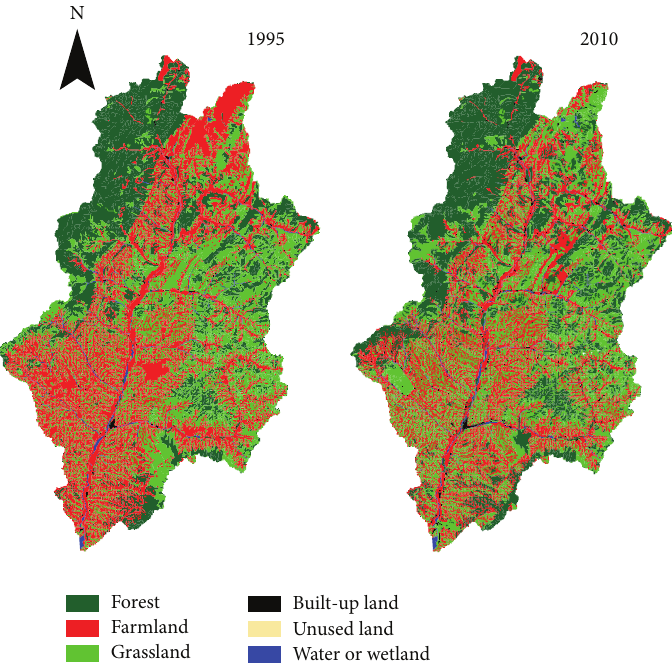
Figure 3: Maps for land uses and land cover in 1995 and 2010 in the Upper Fenhe River watershed. Table 3: Transition matrix of land uses from 1995 to 2010 (km 2 ).